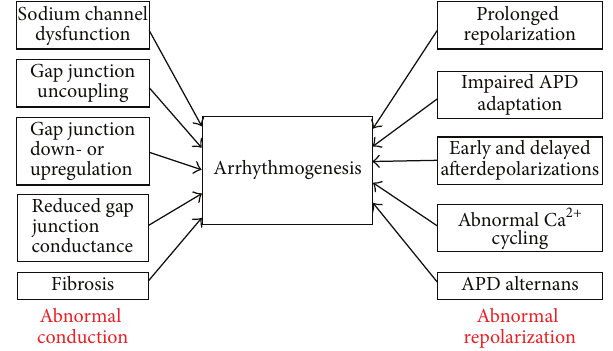
Figure 2: Cardiac and extracardiac factors responsible for promot- ing arrhythmogenesis in